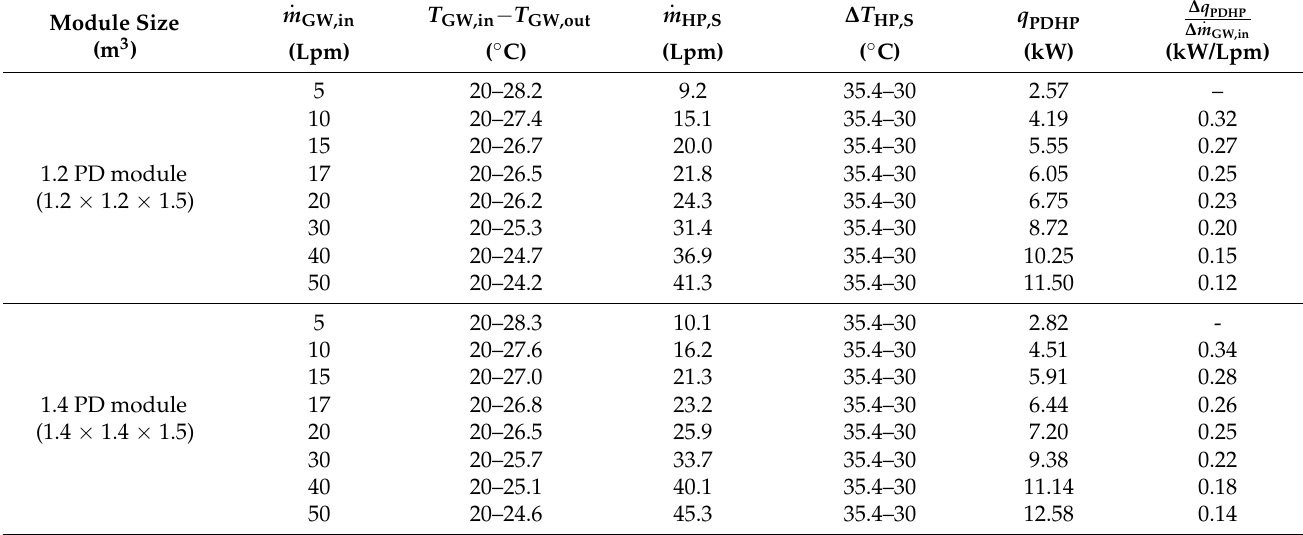
Table 6. PD module sizing results for constant ∆ T HP,S (= LST − EST) of 5.4 ◦ C (marked by a square in Figure 10).